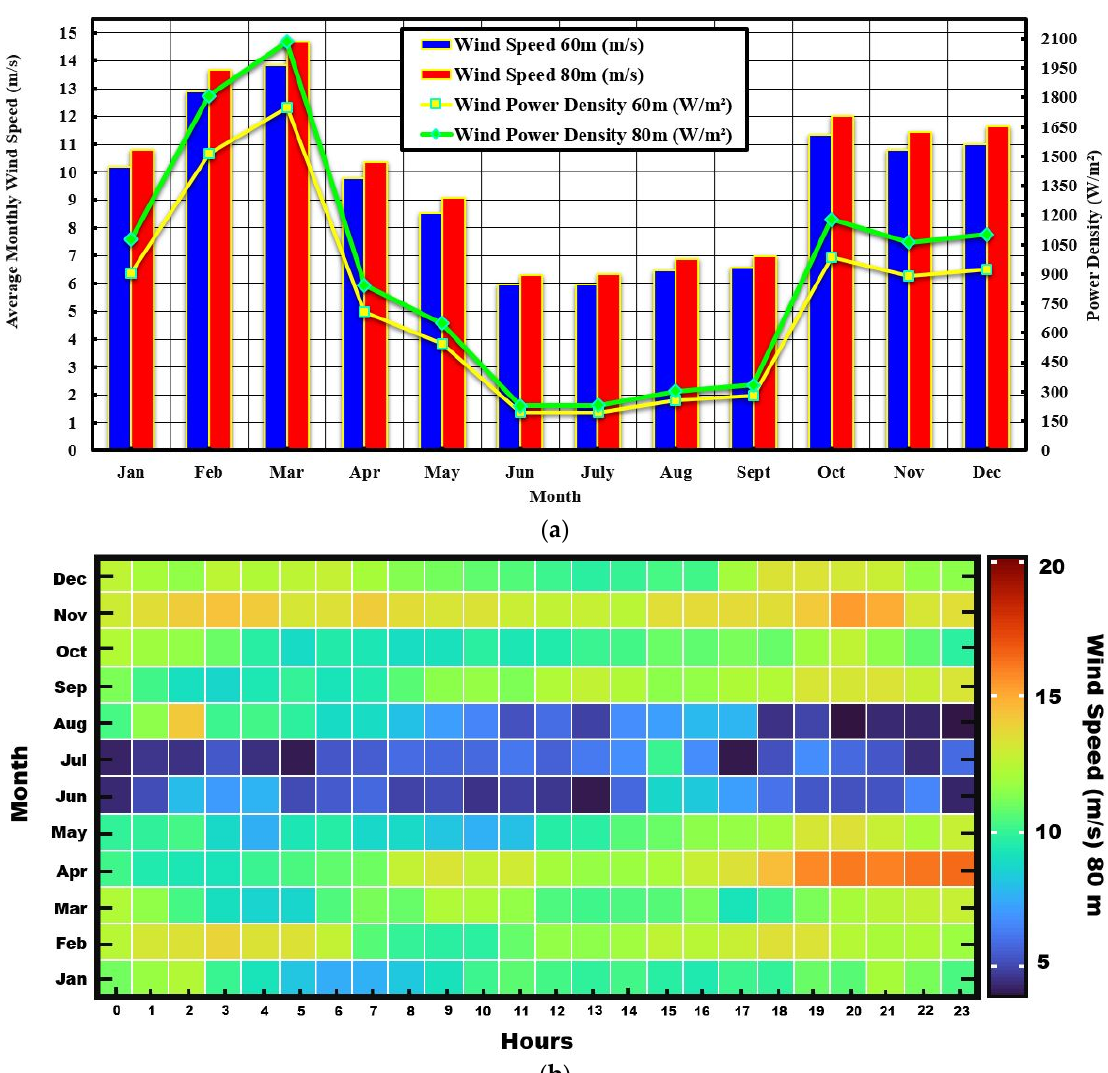
Figure 7. ( a ) Monthly average wind speed and wind power density at Ghoubbet and ( b ) Hourly pattern available wind speed at 80 m.